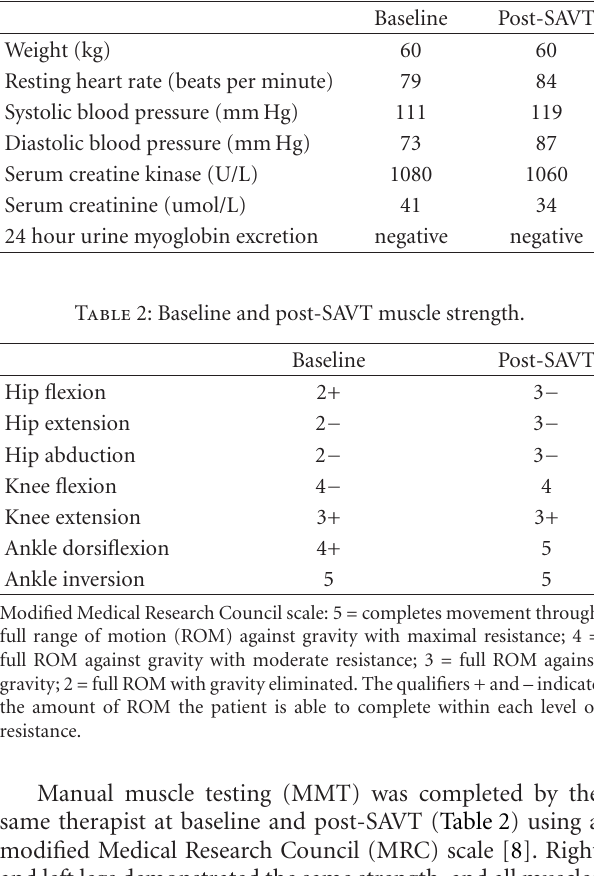
Table 1: Baseline and post-SAVT physical parameters and bio- chemistry data.